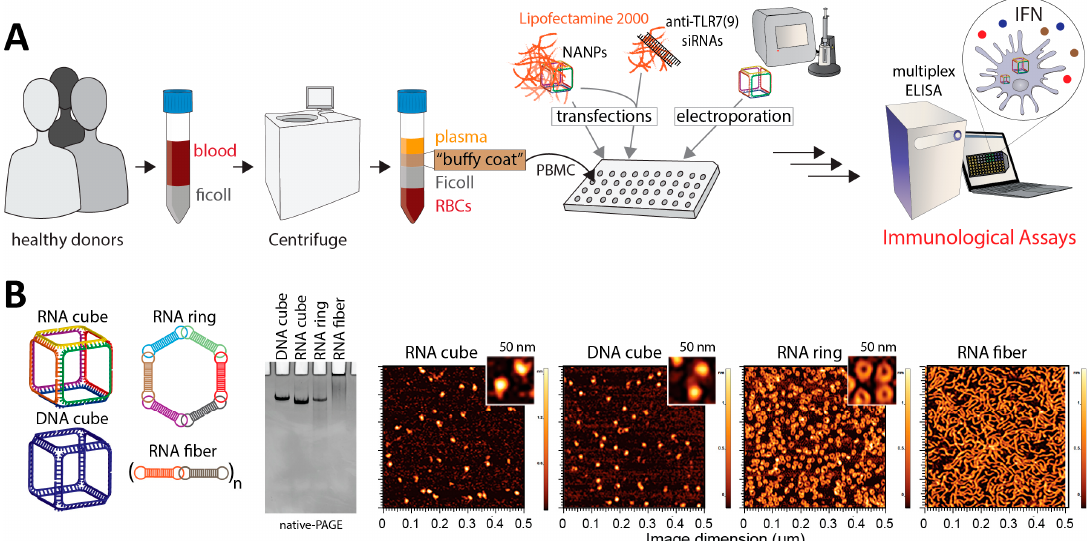
Figure 1. Schematic design of the current study and experimental verification of nucleic acid nanoparticles’ (NANPs’) assemblies. ( A ) Blood from healthy donors was used as a source of peripheral blood mononuclear cells (PBMC), then treated with NANPs with and without prior exposure to the Toll-like receptor (TLR)-inhibiting siRNAs. NANPs were delivered into the cells either by lipofection or electroporation. Type I interferon (IFN) secretion was measured in the culture supernatants by enzyme-linked immunosorbent assay (ELISA). ( B ) RNA cubes, DNA cubes, RNA rings, and RNA fibers were used as model NANPs. All NANPs’ assemblies were confirmed by ethidium bromide total staining native-PAGE and AFM.